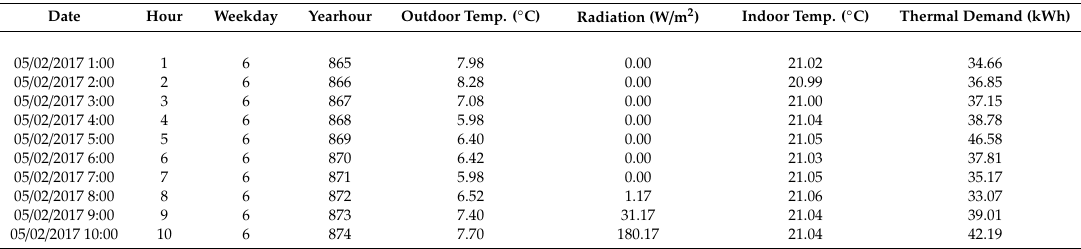
Table 1. Summary of the data set, with the available variables, used in this